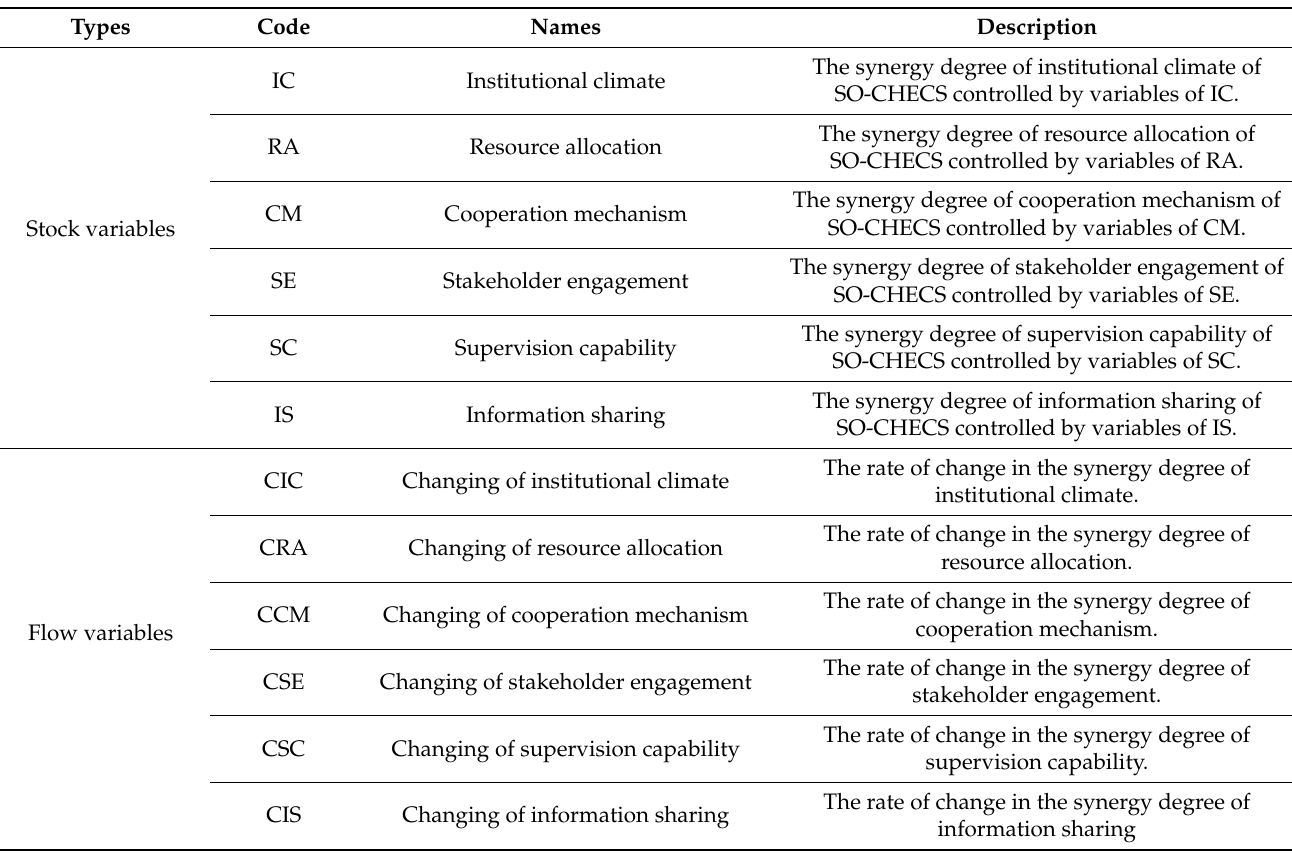
Figure 9. The stock-flow diagram. Table 1. The definition of variables and constants.